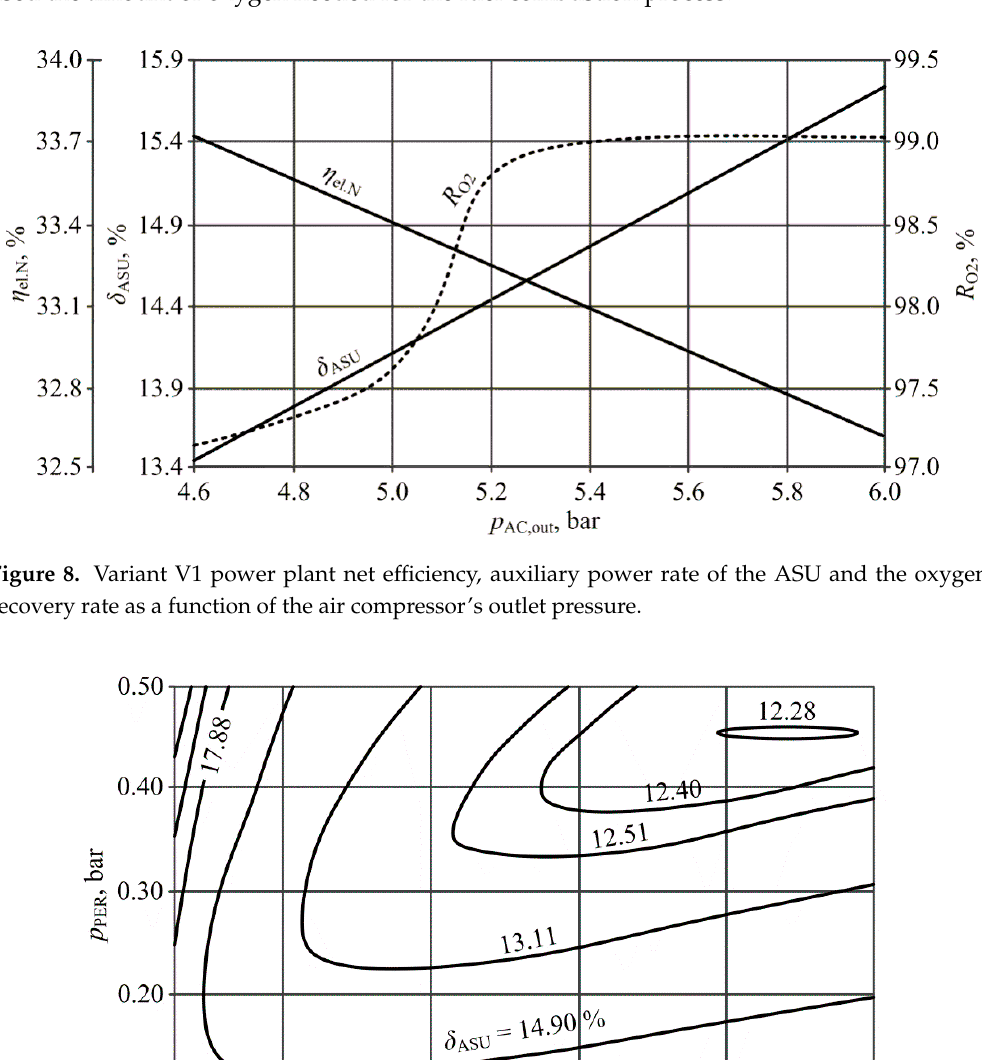
Figure 8. Variant V1 power plant net efficiency, auxiliary power rate of the ASU and the oxygen recovery rate as a function of the air compressor’s outlet pressure.